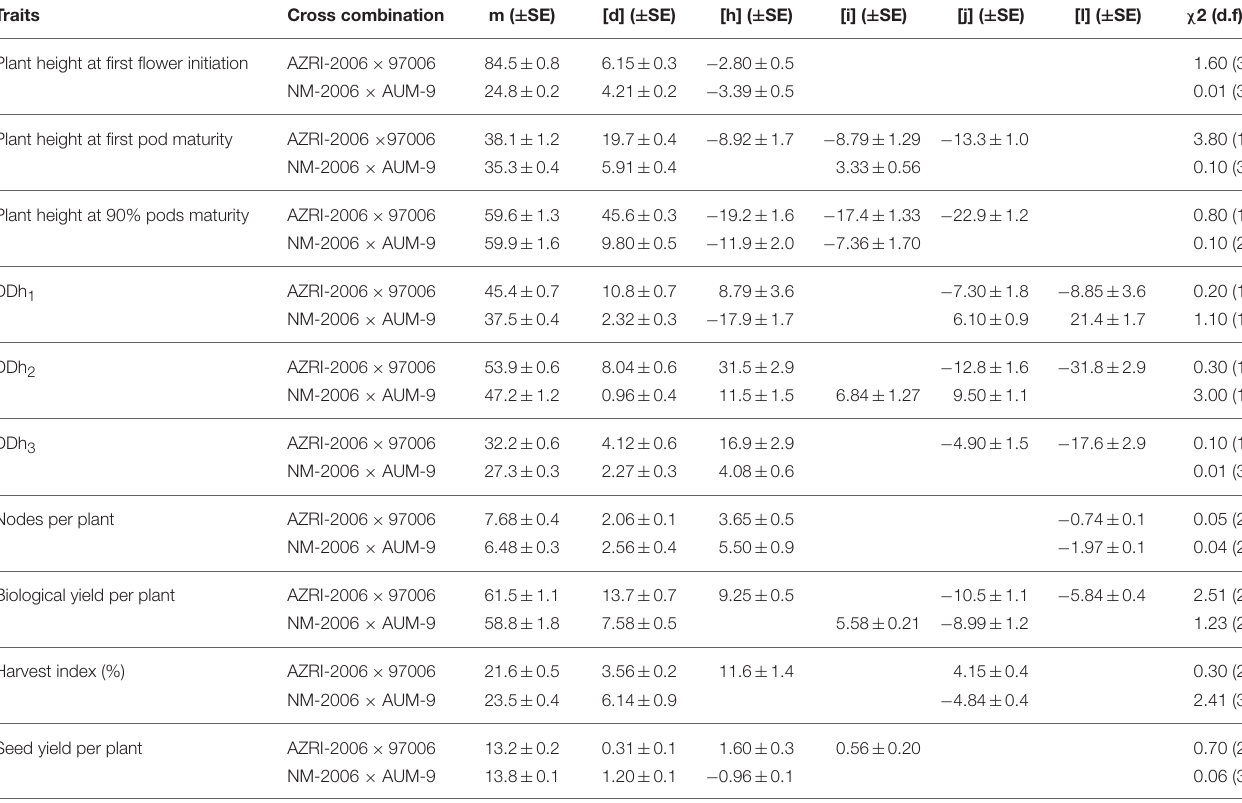
TABLE 4 | Estimates of gene effects with standard error and χ 2 values of the fitted models for plant height and related traits in mungbean.